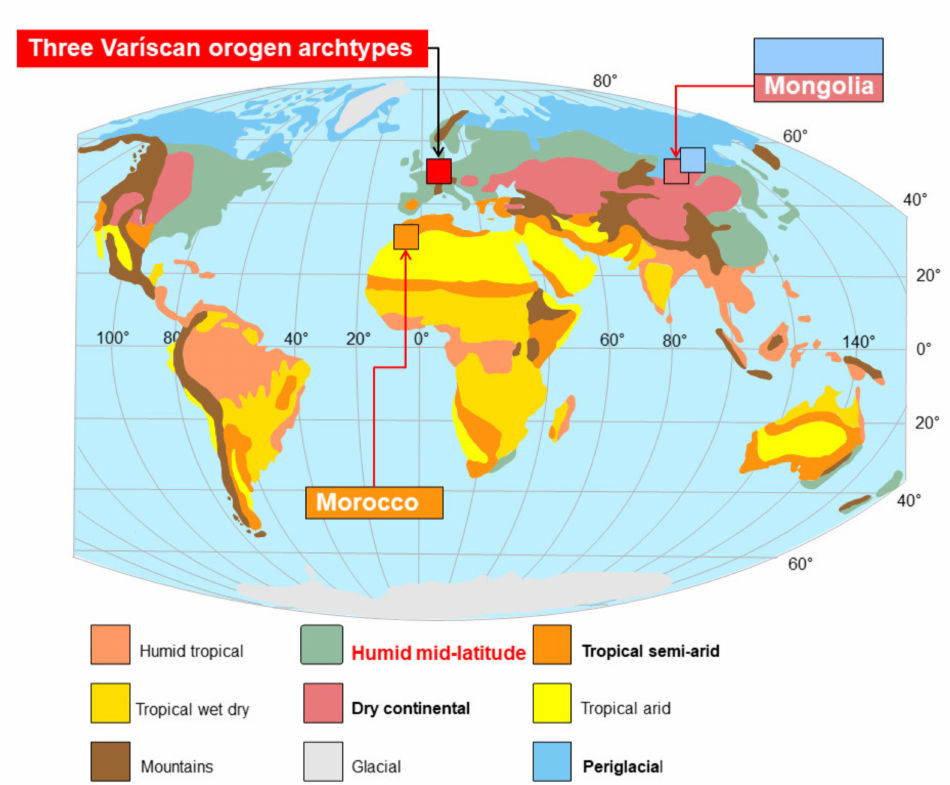
Figure 18. The position of the study areas referred to in the text in relation to morphoclimatic zonation of the globe during the period of time < 2 Ma/Quaternary (modified from Tricart and Cailleux, 1972; Scotese, 2002 [181,182] http://www.scotese.com/legend.htm) (accessed on 10 February